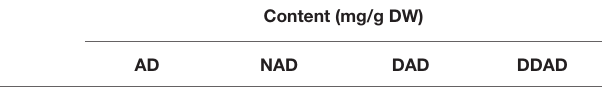
TABLE 5 | The content of andrographolide (AD), neandrographolide (NAD), 14-deoxyandrographolide (DAD), and 14-deoxy-11,12-didehydroandrograph (DDAD) ( n =